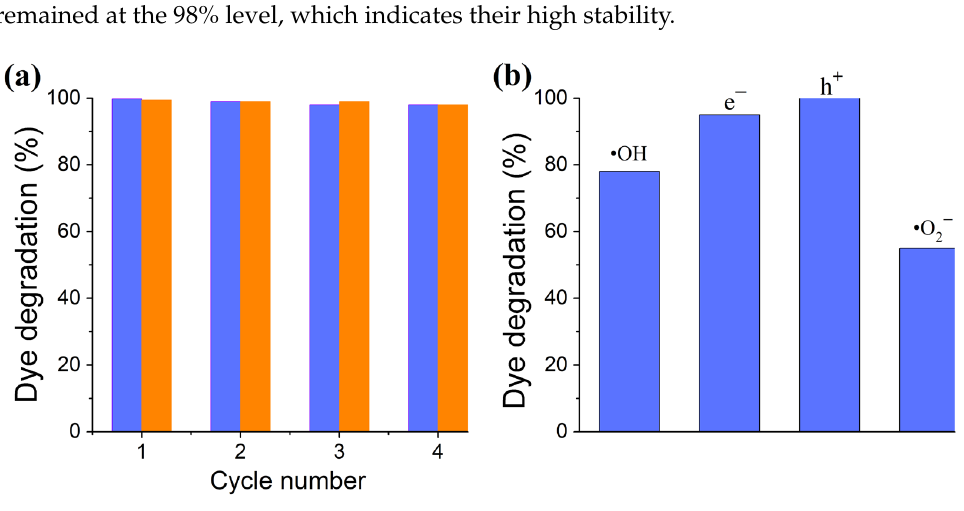
Figure 10. Photocatalytic activity and stability of BNO 1 and BNO 2 nanoparticles during the degradation of MB under UV irradiation (45 min) in four successive cycles (blue and orange colors correspond to 6.5 and 4.2 at.% of oxygen) ( a ); results of scavenger testing of the BNO 1 sample ( b ).